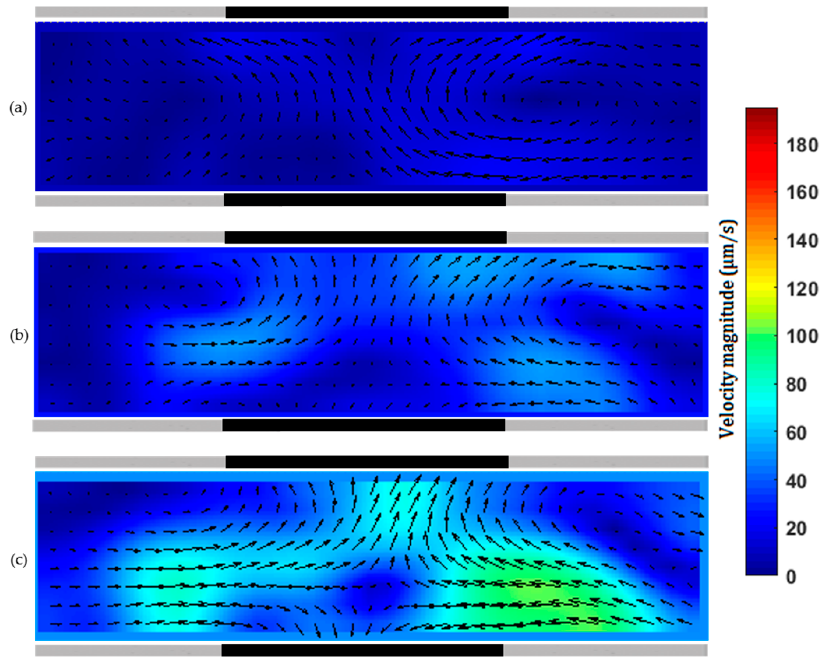
Figure 5. ACEO flow of 1 mM KCl solution between two 0.5 mm pencil-lead electrodes facing each other in a microchannel of 0.3 mm diameter. AC voltage of ( a ) 30 V p-p ; ( b ) 35 V p-p ; ( c ) 40 V p-p with a frequency of 50 kHz.